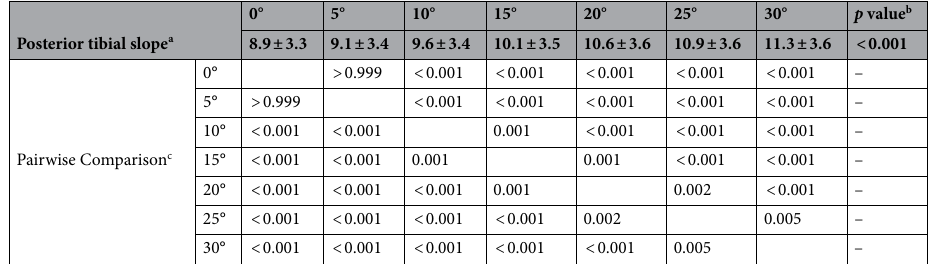
Table 3. Comparison between the postoperative posterior tibial slopes measured on the 3D models where the anteriorly inclined osteotomy and pairwise comparison. a The values are presented as mean ± standard deviation. b Analyzed by repeated measured analysis of variance (ANOVA). c Adjusted p value obtained by Bonferroni